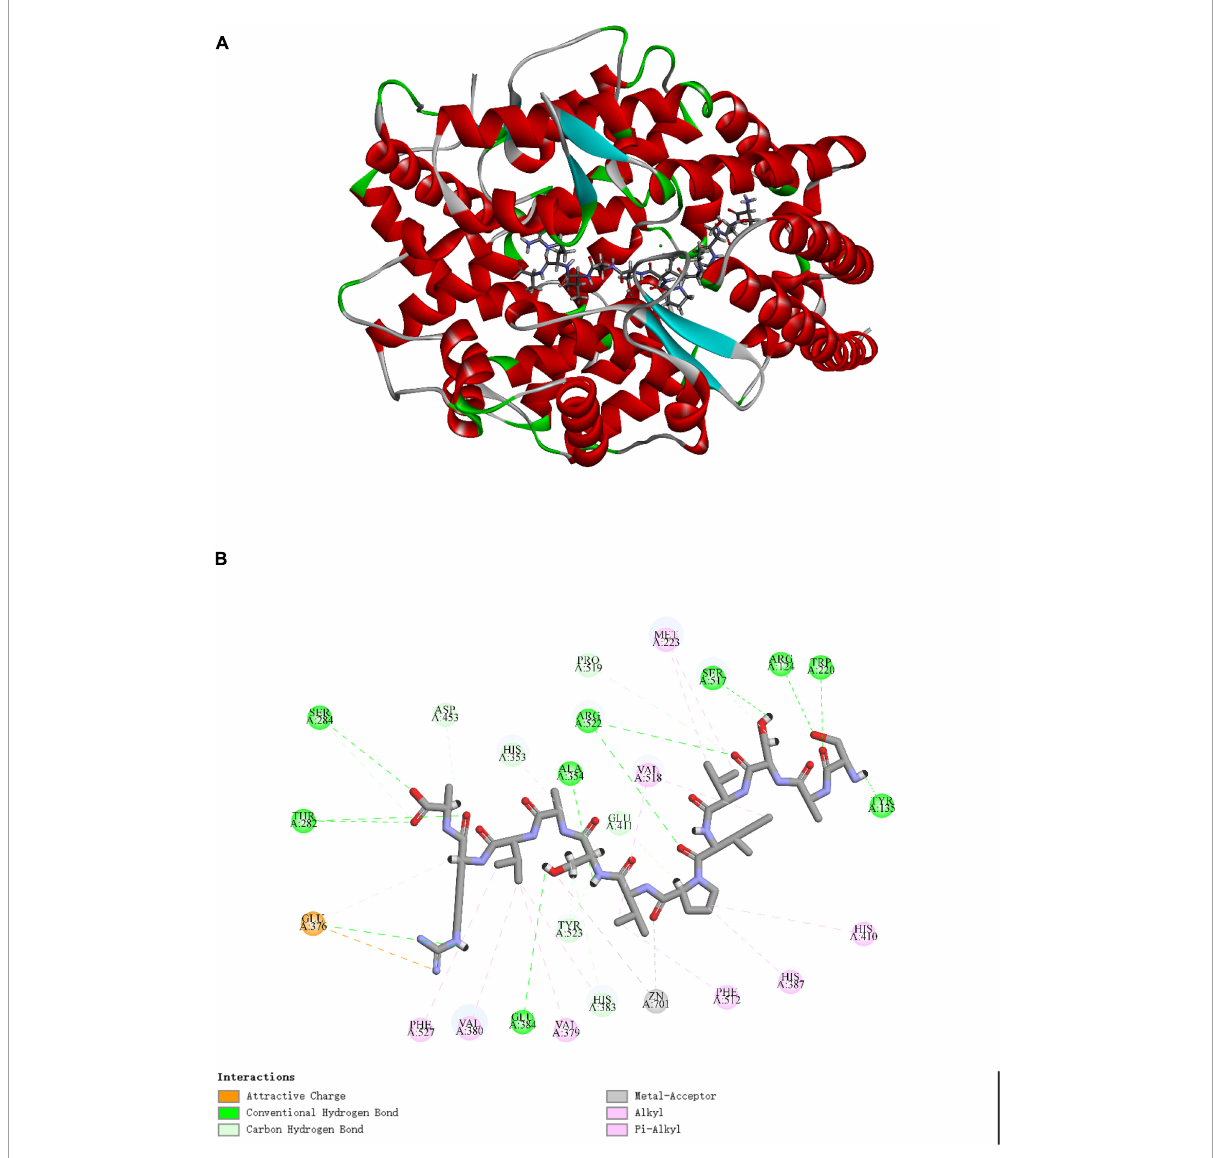
FIGURE5 Diagram of SASVIPVSAVRA binding with ACE. (A) The optimal docking structure diagram of SASVIPVSAVRA binding with ACE (PDB: 1O8A). (B) The 2D diagram of the interaction between SASVIPVSAVRA and ACE amino acid